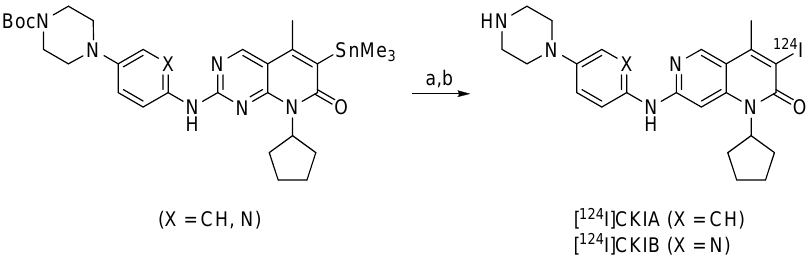
receptor ligand [ 124 1